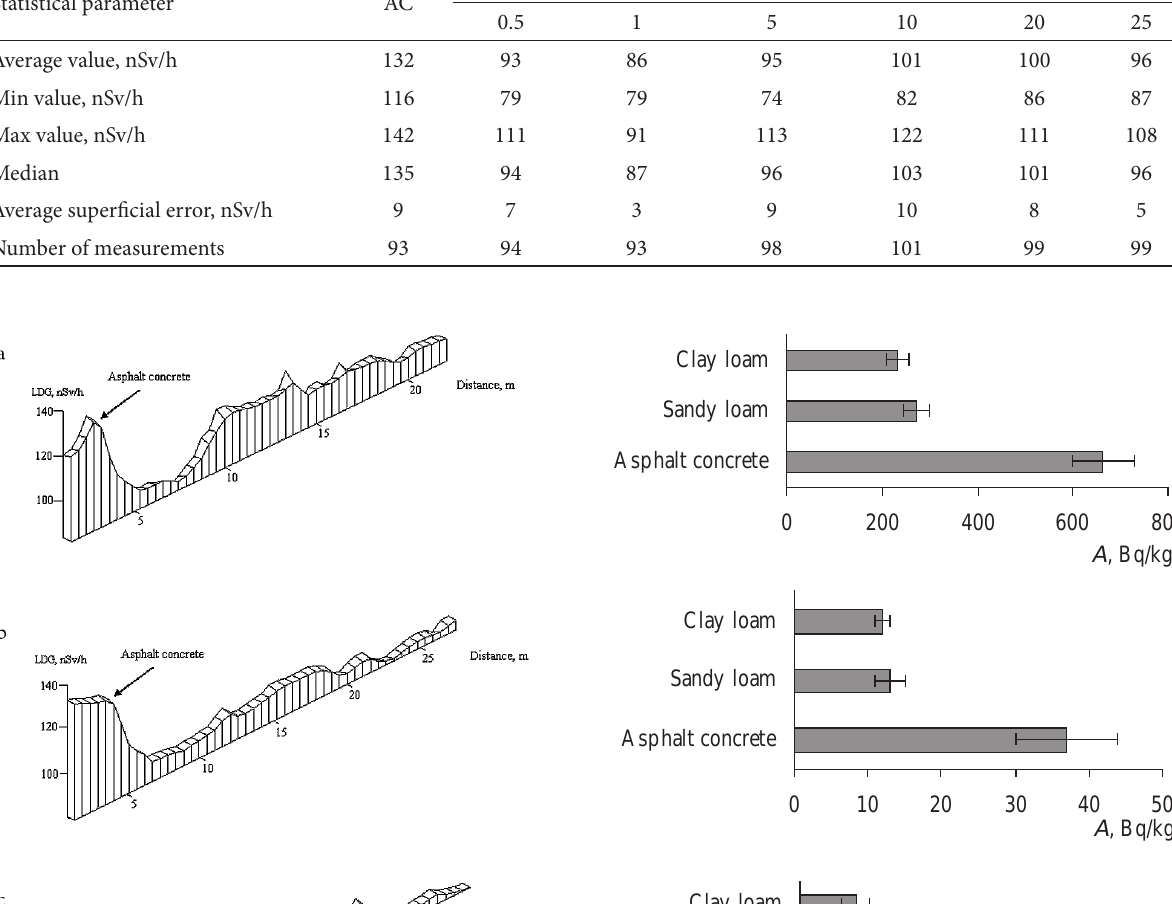
Table 2. Statistical data of EDR above AC and soil Statistical parameter